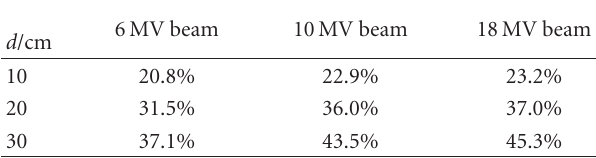
Table 5: The DQE at zero frequency of CPID for three clinical beams. Statistical uncertainties for each value is ∼ 0.8%.